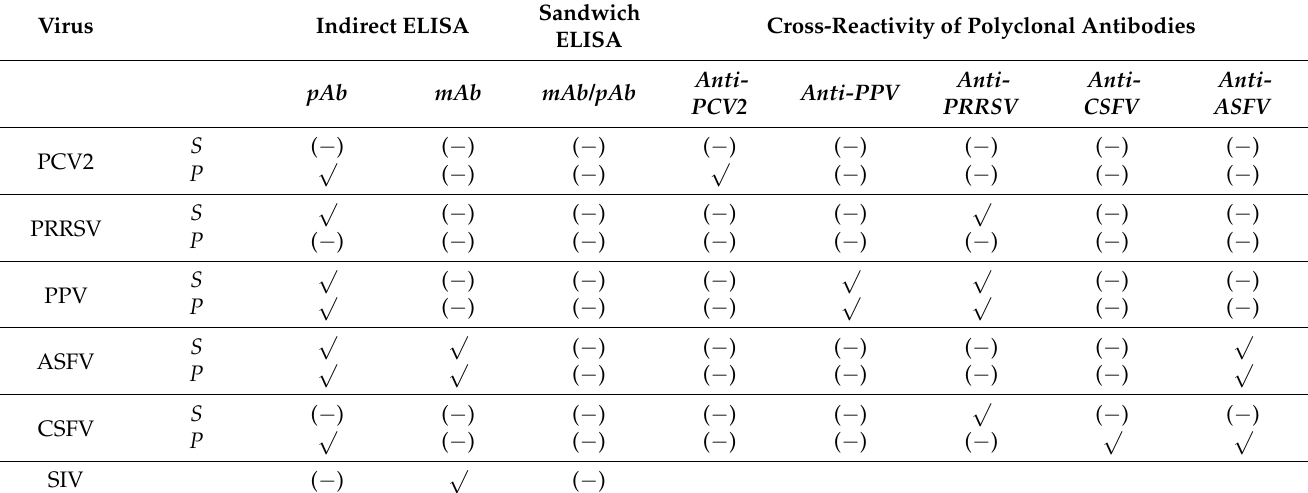
Table 2. Summary of results obtained by indirect and sandwich ELISA